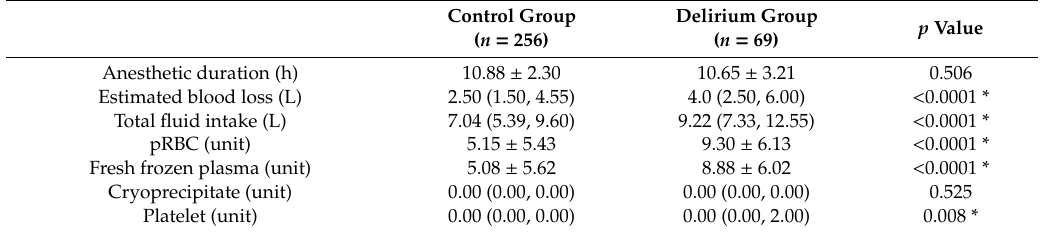
Table 3. Perioperative factors in patients undergoing liver transplantation. Control Group ( n =